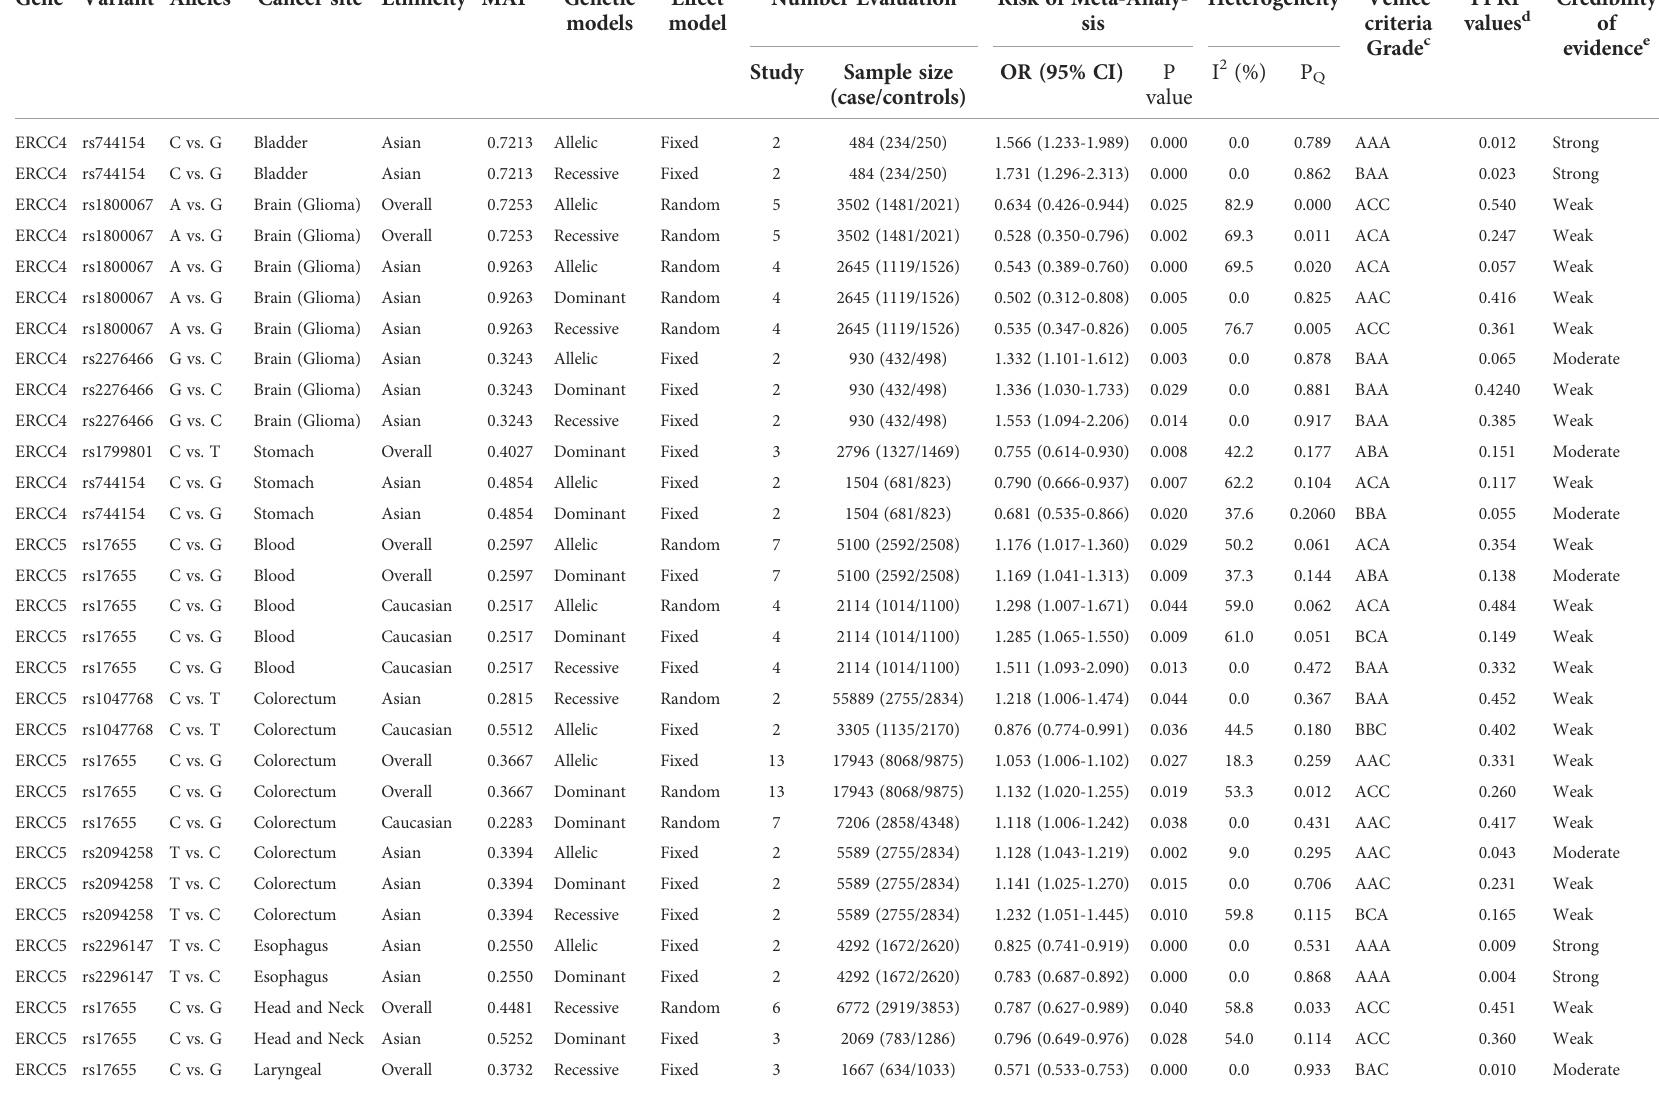
TABLE 1 Genetic variants showing signi fi cant summary odds ratios for different cancer risks in main meta-analyses in all three genetic models. Gene Variant Alleles a Cancer site Ethnicity MAF b